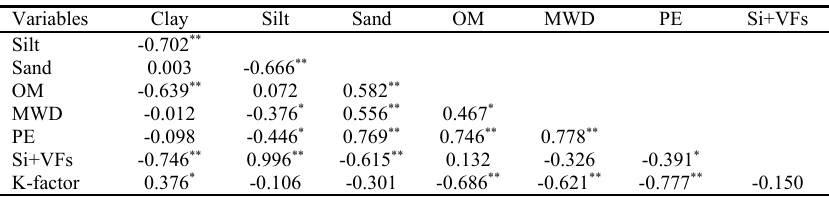
Table 5: Correlation between soil properties and USLE K-factor